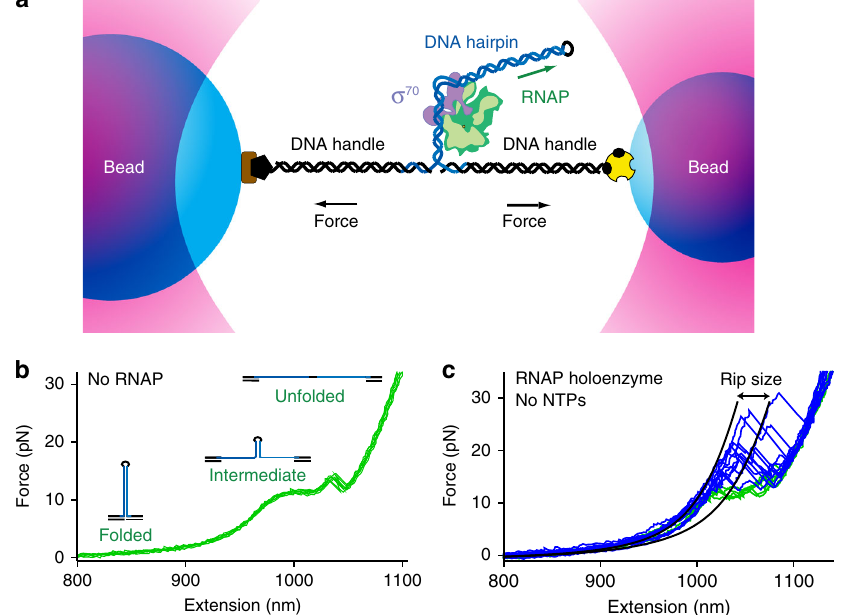
Fig. 1 The optical-trapping assay. a Cartoon illustrating the “ dumbbell ” assay for transcription initiation (not to scale). Two polystyrene beads are held in individual optical traps. DNA handles are attached to the two beads via biotin-avidin (yellow) and digoxiginin-antidigoxiginin (brown) linkages. A DNA hairpin (blue) carrying a promoter region in its stem is annealed to the handles (black) on both ends. RNAP holoenzyme binds the promoter and transcribes towards the hairpin loop (black). b Representative FECs of the hairpin bearing a T7A1 promoter, extending from − 56 to +20, in the absence RNAP. c FECs collected with holoenzyme present, with either RNAP bound (blue) or not bound (green). All data were obtained using the same promoter construct. WLC fi ts to the data before and after a rip in a representative record (black